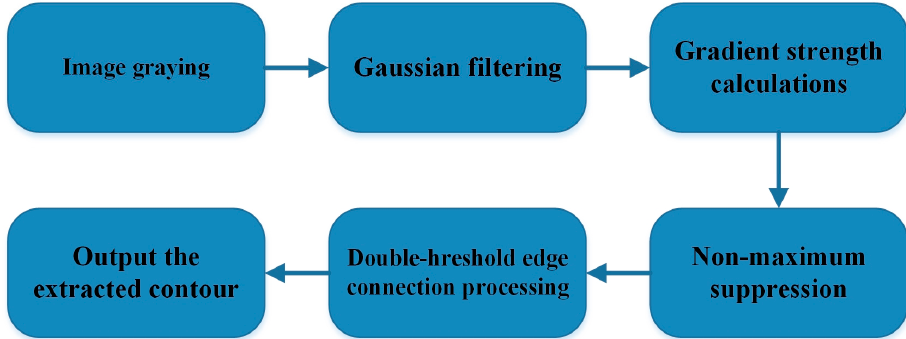
Figure 6. The overall technical roadmap of the Canny edge detection algorithm.